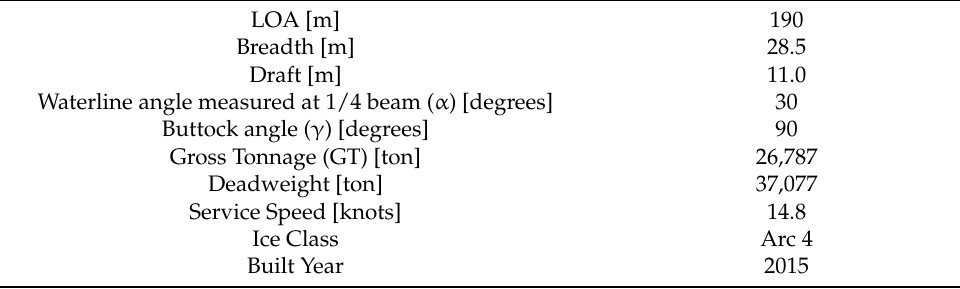
Table 2. Particulars of the case study